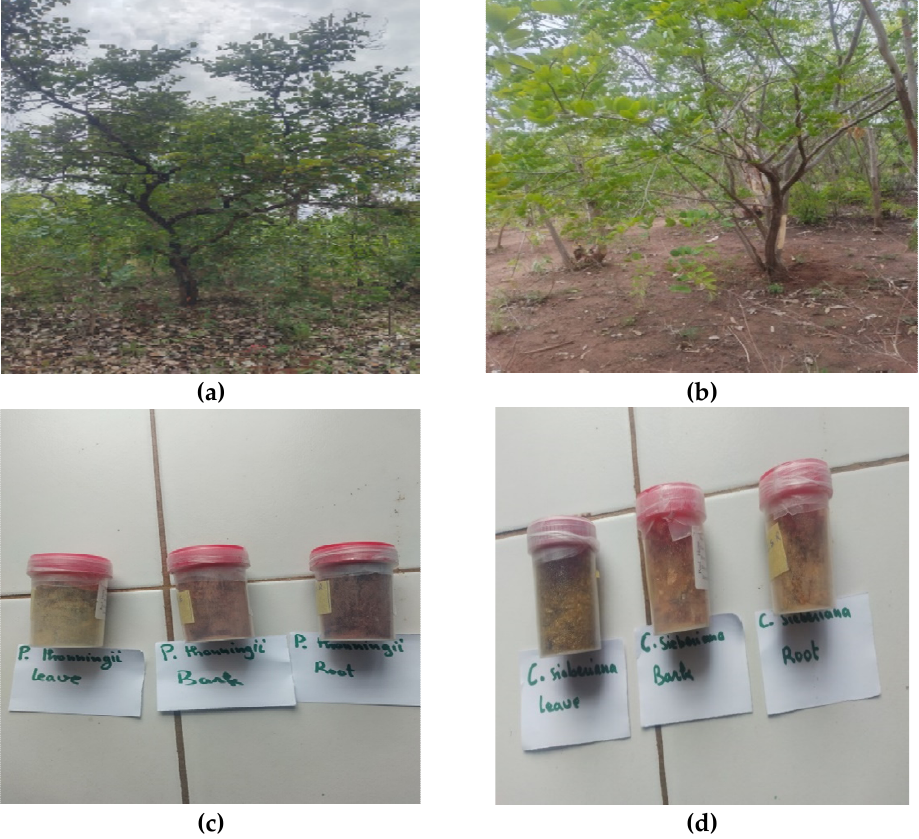
Figure 3. The plants: ( a ) P. thonningii and ( b ) C. sieberiana from the Hauts-Bassins region, Bobo- Dioulasso, Dienderesso forest. The powder extracts from leaves, roots, and bark of ( c ) P. thonningii and ( d ) C. sieberiana .